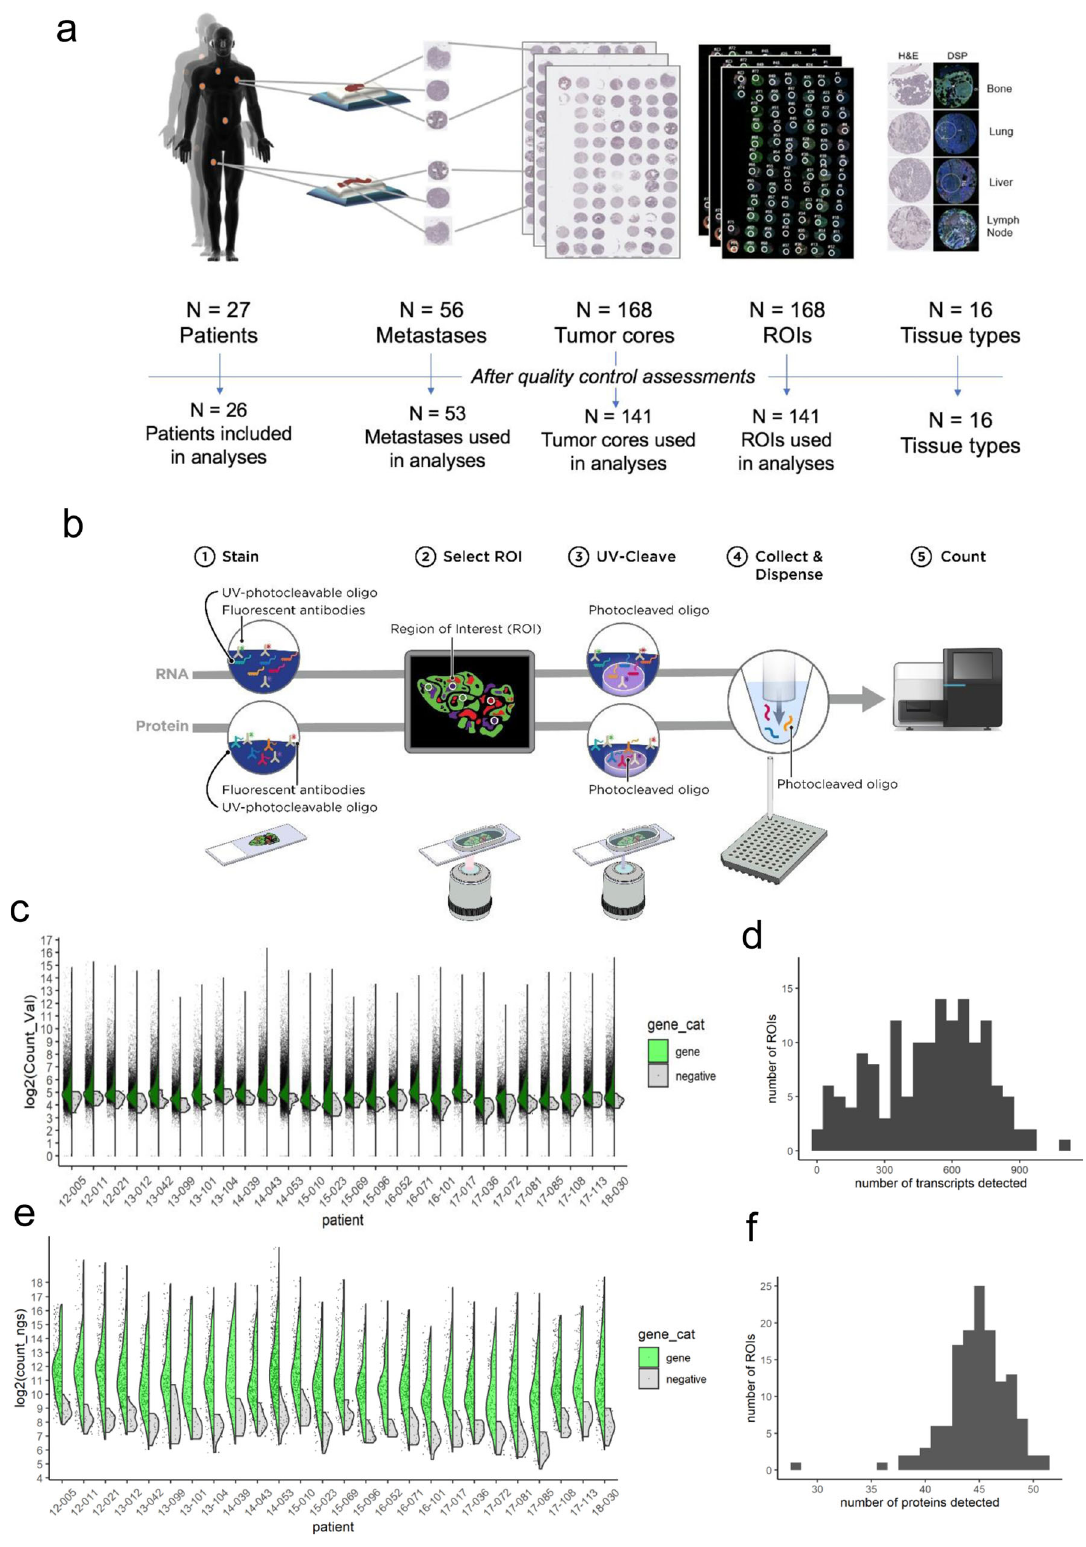
For the RNA DSP, probe counts were collapsed to gene counts by fi rst removing outlier probes and then taking the geometric mean of remaining probes for each gene in each ROI. Gene and negative count distributions for each patient ( N = 6 ROIs for most patients) are shown in Fig. 1c. Negative probe